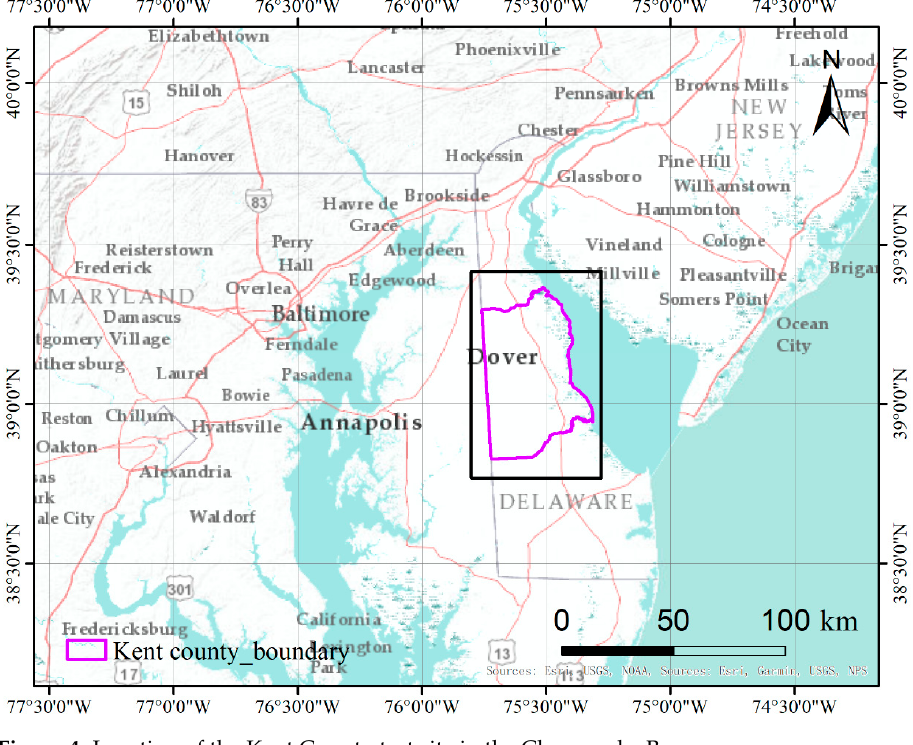
Figure 4. Location of the Kent County test site in the Chesapeake Bay area.